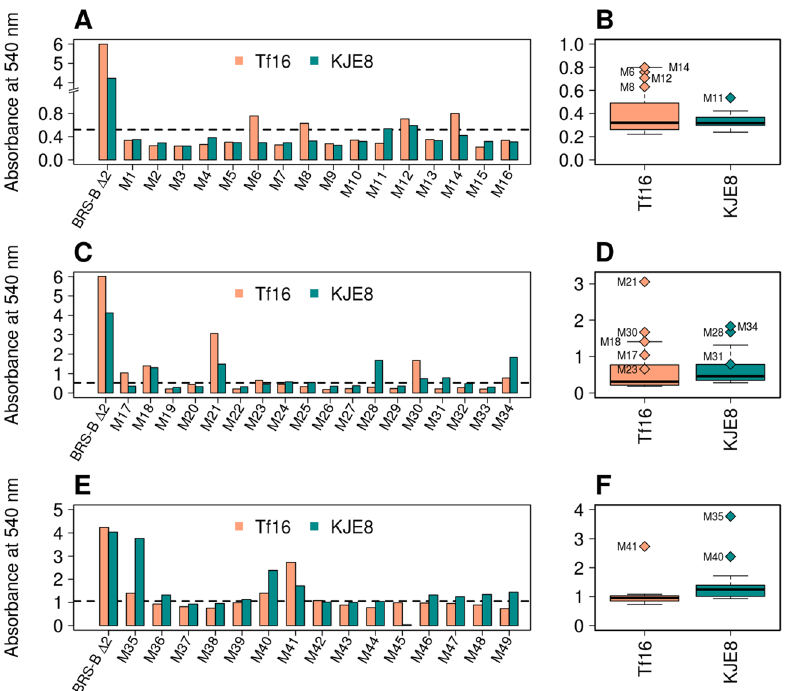
Figure 4. ( A , C , E ): Absorbance at 540 nm determined after the reducing sugar “ON/OFF” assay using crude enzyme extracts of the 49 mutants co-produced with either tig (Tf16, light salmon) or dnaK , dnaJ , grpE , groES , groEL chaperone proteins (KJE8, dark cyan) in presence of 100 g L −1 sucrose during 70 h incubation. The parental enzyme BRS-B Δ2 is indicated as a reference. Dashed lines indicate absorbance level of the inactive mutant BRS-B Δ2 E709Q. ( B , D , F ) boxplot representing the absorbance data. Parental enzyme BRS-B Δ2 was excluded from the analysis. Data points (diamonds) pinpoint the 16 mutants selected for further